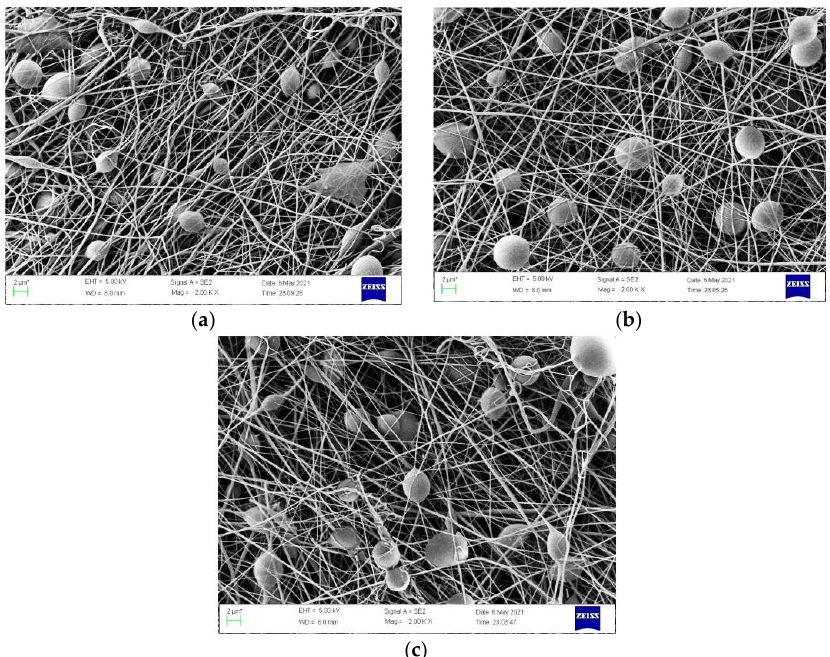
Figure 2. SEM photos show the effects of the flow rate on the morphology of the TTO/PCL micro- spheres in TTE-PVP-3/TTO-PCL after electrospinning for two minutes: ( a ) 0.07mm min − 1 , ( b ) 0.08mm min − 1 , ( c ) 0.09mm min − 1 .